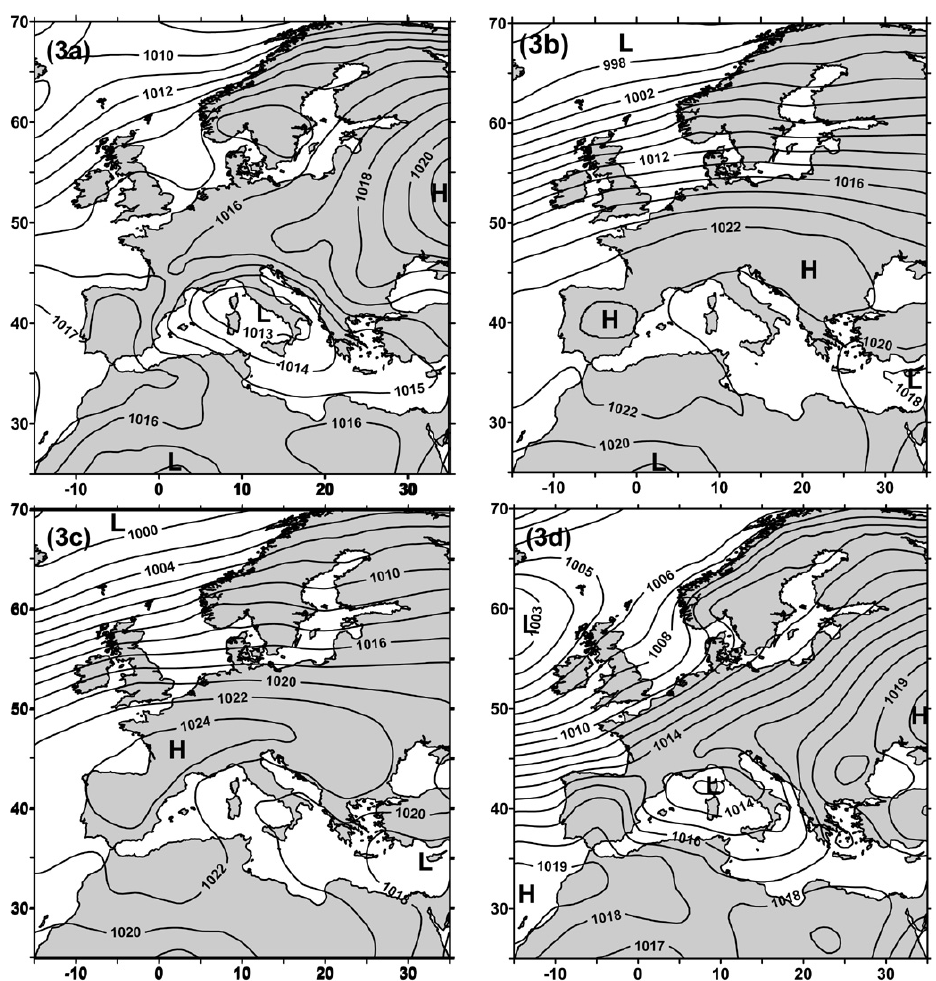
Figure 3. Composite SLP (in hPa) distribution for: (a) the lowermost 10% extreme values of SW occurring within the period 1958–2001 in South Aegean during winter, (b) the uppermost 10% SW values, (c) the lowermost 10% LH values and (d) the uppermost 10% LH